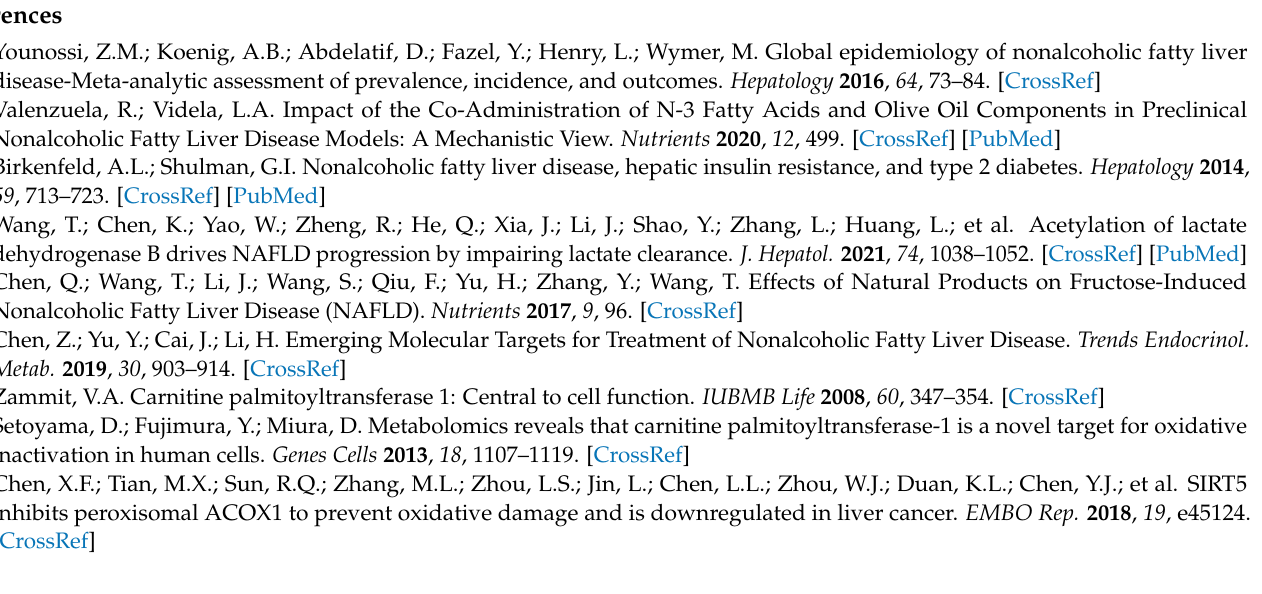
Figure S2: Effects of FA supplementation on food intake (A) and energy intake (B) in HFD-fed mice. Figure S3: Effects of FA supplementation on hepatic β -hydroxybutyric acid in HFD-fed mice. Figure S4: The expression of genes involved in lipolysis and fatty acid oxidation in brown adipose tissue. Figure S5: Effects of FA supplementation on serum(A) β -hydroxybutyric acid and free fatty acid (B) concentration in HFD-fed